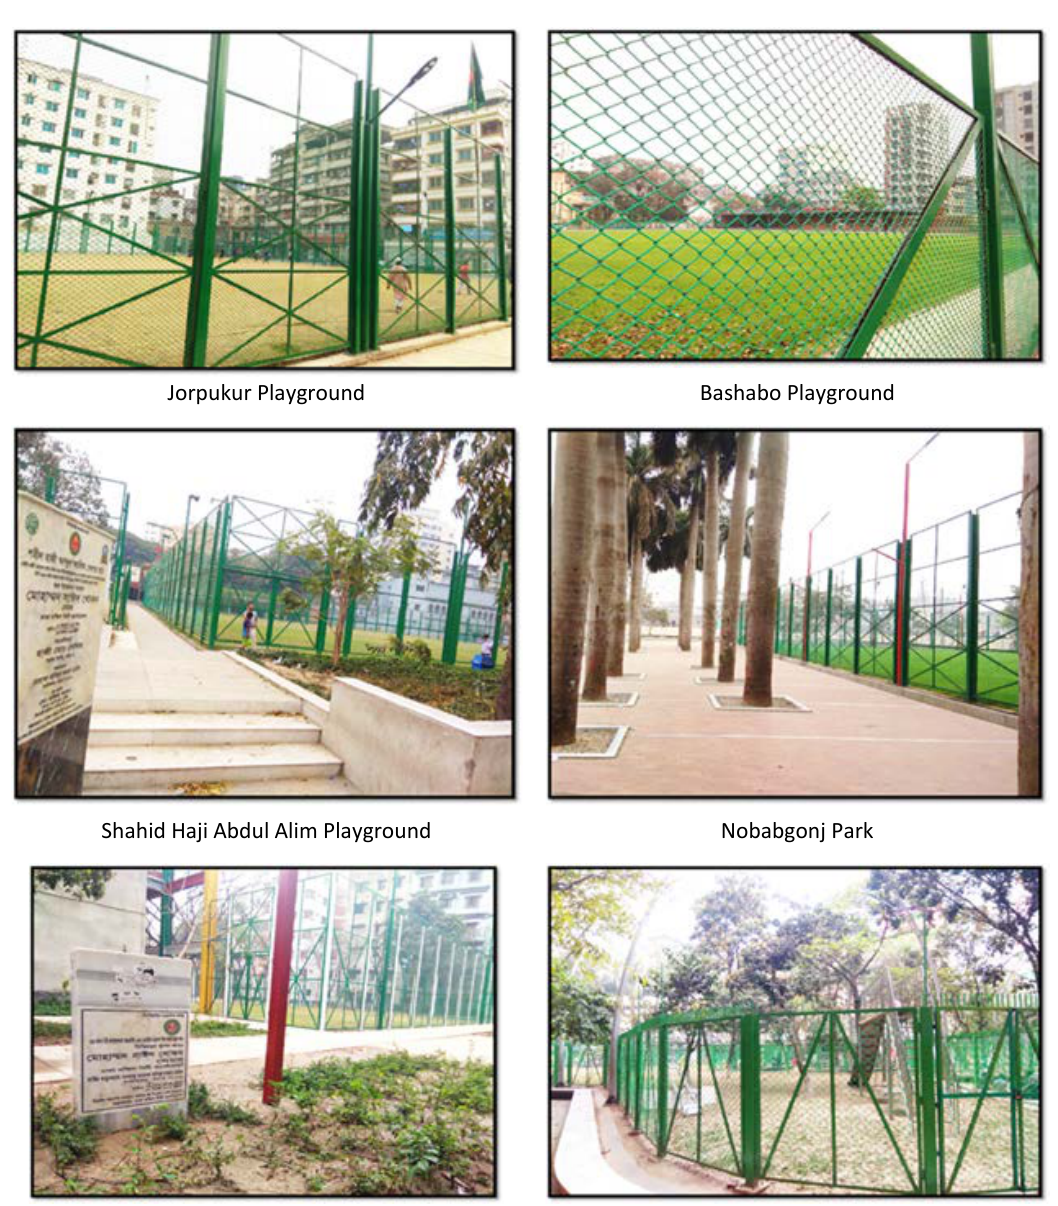
Fig. 2: Selected parks and playgrounds